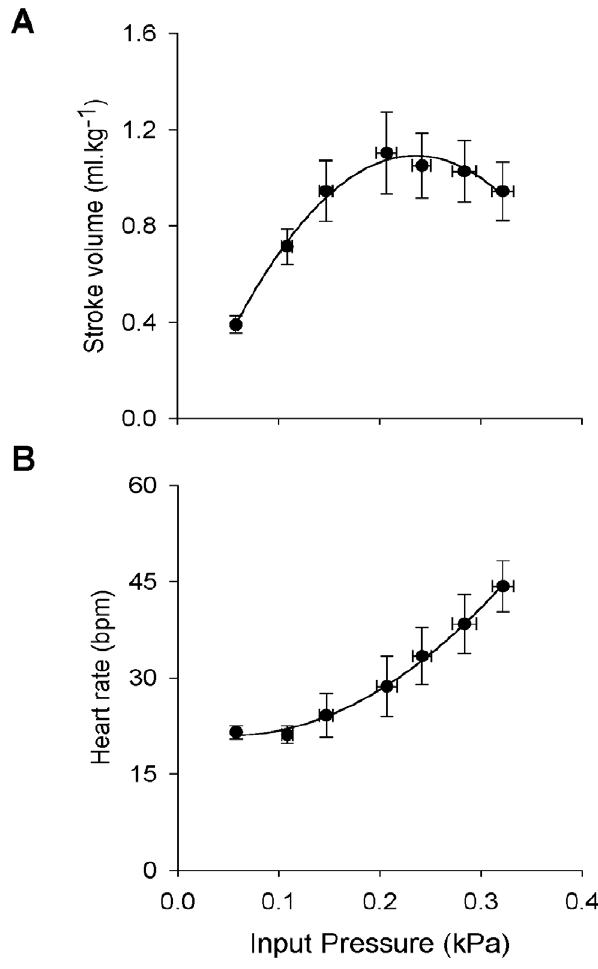
Figure 3. Hemodynamics of the isolated trout working heart. (A) The Frank-Starling relationship in the spontaneously beating isolated heart. SV increases to a maximum (1.10 6 0.17 ml kg 2 1 ) at a P i of 0.21 6 0.12 kPa after which it declines ( p , 0.05, One-Way RM ANOVA, Student-Newman-Keuls post hoc , not shown). (B) The increase in heart rate with increasing P i in the spontaneously beating rainbow trout heart with a P o of 0.5 kPa ( p , 0.05, one way RM ANOVA, Student- Newman-Keuls post hoc , not shown). Lines represent polynomial fits of the data (all data are means 6 S.E.M. of n=8 hearts at 11 u C).